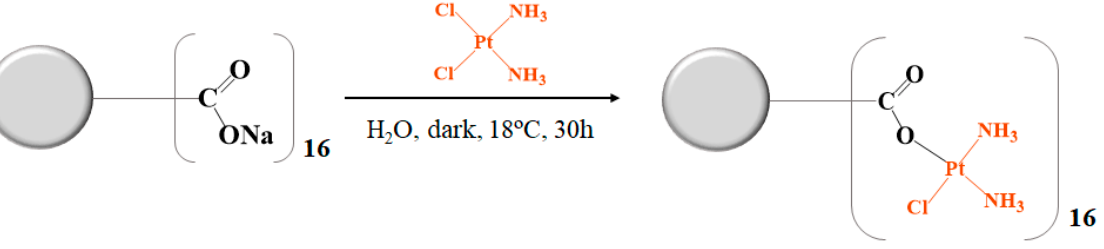
Scheme 2. Representation of the synthesis of the PAMAM dendrimer G1.5 functionalized with cisplatin in monodentate form, G1.5(COOPt(NH 3 ) 2 Cl) 16 . G2.5COONa PAMAM Dendrimer with Cisplatin–G2.5(COOPt(NH 3 ) 2 Cl) 32